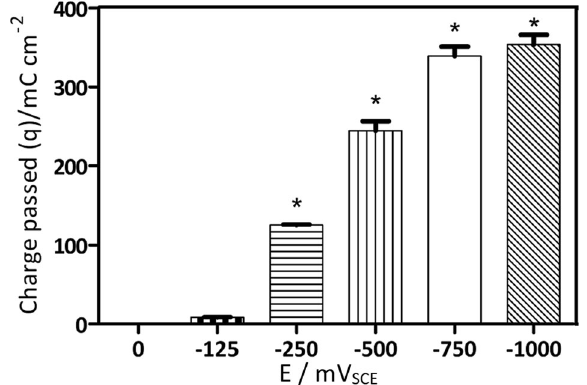
Fig. 11 Variation of charges passed per unit CFRP surface area with applied potential. Charges passed per unit of surface area in CFRP immersed in 50 m NaCl at different impressed potentials (from − 1000 to 0 mV SCE ) during 4 h (Error bars within graph represent standard deviations of mean, asterisks denote potentials at which the speci fi c charge passed were statistically signi fi cant ( P < Fig. 10d. From Fig. 10d, it can be observed that the calculated length of the diffusion layer is in the range of 0.42 to 0.58 mm and that the lower limit of calculated values are obtained at potentials more cathodic than − 375 mV SCE . Interestingly, it is above this potential value ( ≈ − 375 mV SCE ) that other cathodic processes besides the two- electron reduction process are deemed to most probably become